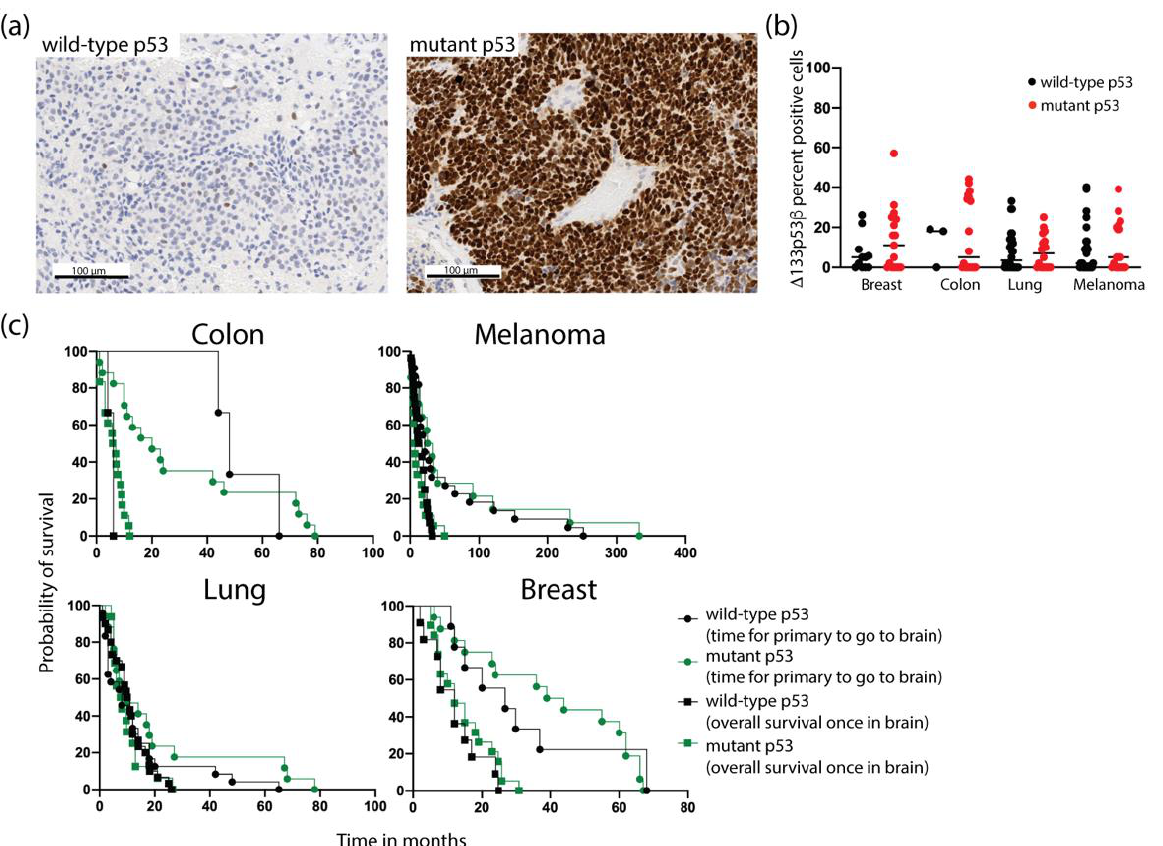
Figure 3. Correlation between mutant p53 and Δ 133p53 β expression in brain metastases. ( a ) Mutant p53 was estimated as intense staining in over 80% of tumor cells using immunohistochemistry. ( b ) Across brain metastases, mutant p53 was not correlated with ∆ 133p53 β mRNA expression from RNAscope analyses. ( c ) Mutant p53 was not associated with altered patient progression time for the primary tumor to metastasize to the brain or with overall survival when the tumor was diagnosed in the brain across different tumor types.